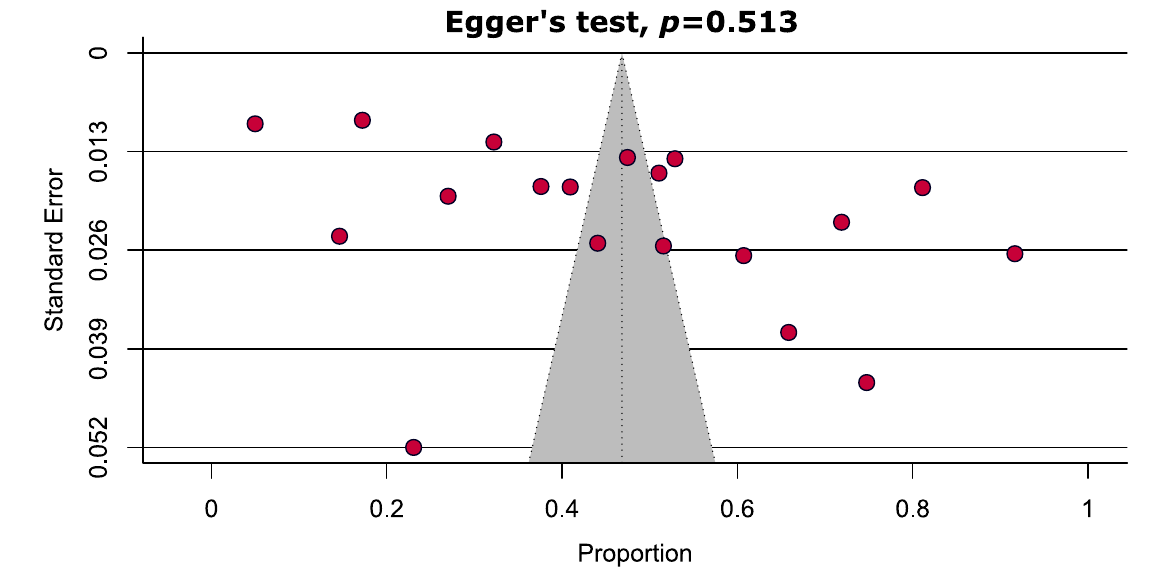
Figure 3. Funnel plot showing no evidence of publication bias estimating the prevalence of anemia in children and adolescents of Bangladesh.